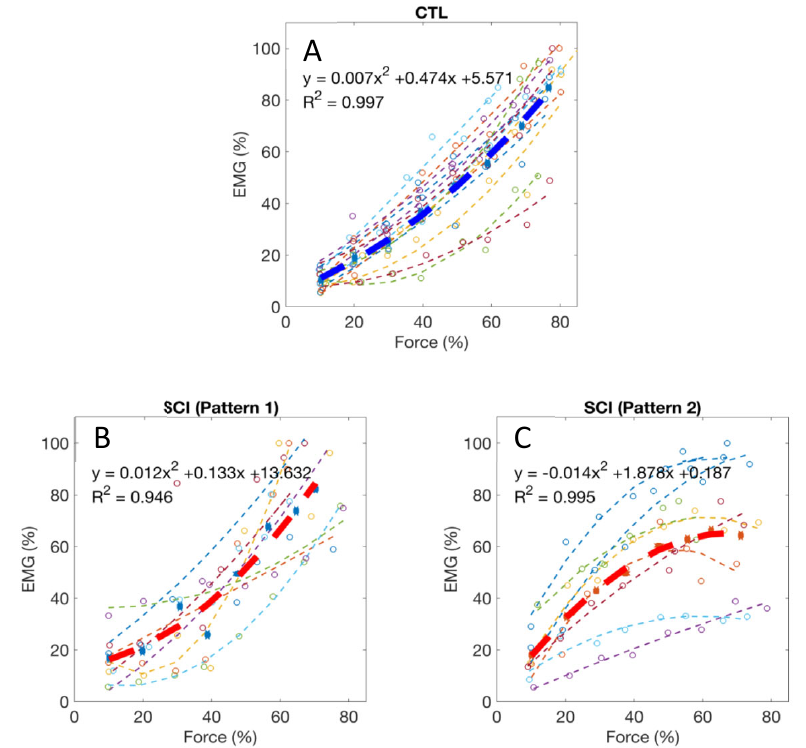
Figure 3. ( A ) Normalized EMG–force relations from all healthy control subjects and the averaged relation (the thick line); ( B , C ) Two typical patterns of EMG–force relations from all the tested SCI subjects and the averaged relations (the thick lines).